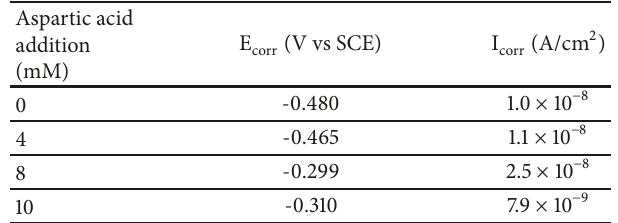
Table 5: Potentiodynamic polarization values for acid pretreatment of CoCrMo alloys (Courtesy of I. Coskun and T.D. Golden, 2018). Aspartic acid E corr (V vs SCE) I corr (A/cm 2 addition (mM)